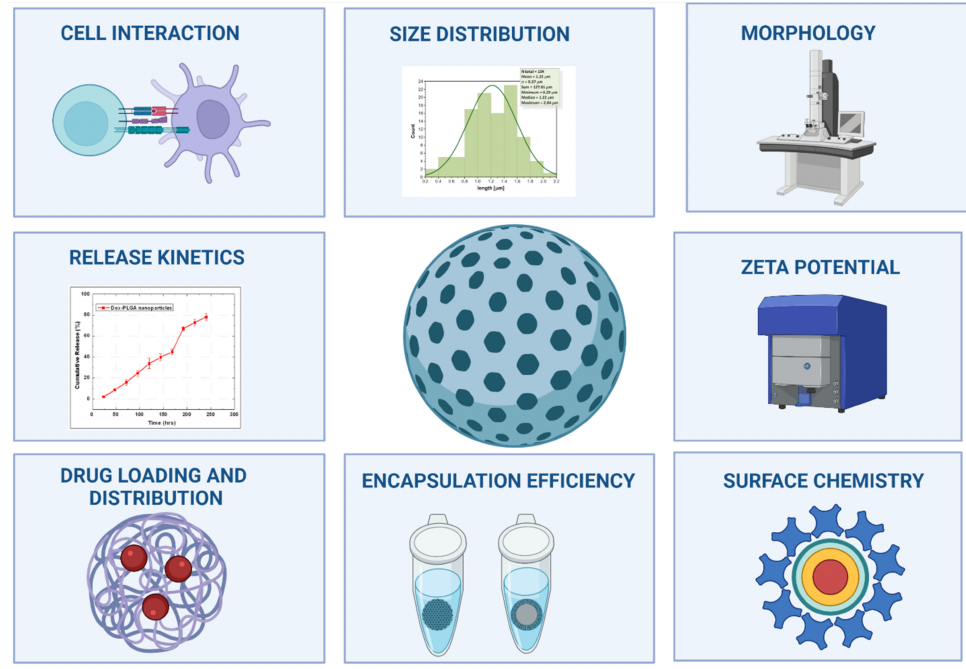
Figure 1. Main parameters to evaluate in the physicochemical characterization of biological NPs. NPs are complex structures that must be well characterized to identify how their qualities influence the quality, safety, and efficacy. Created with BioRender.com (accessed on 10 December